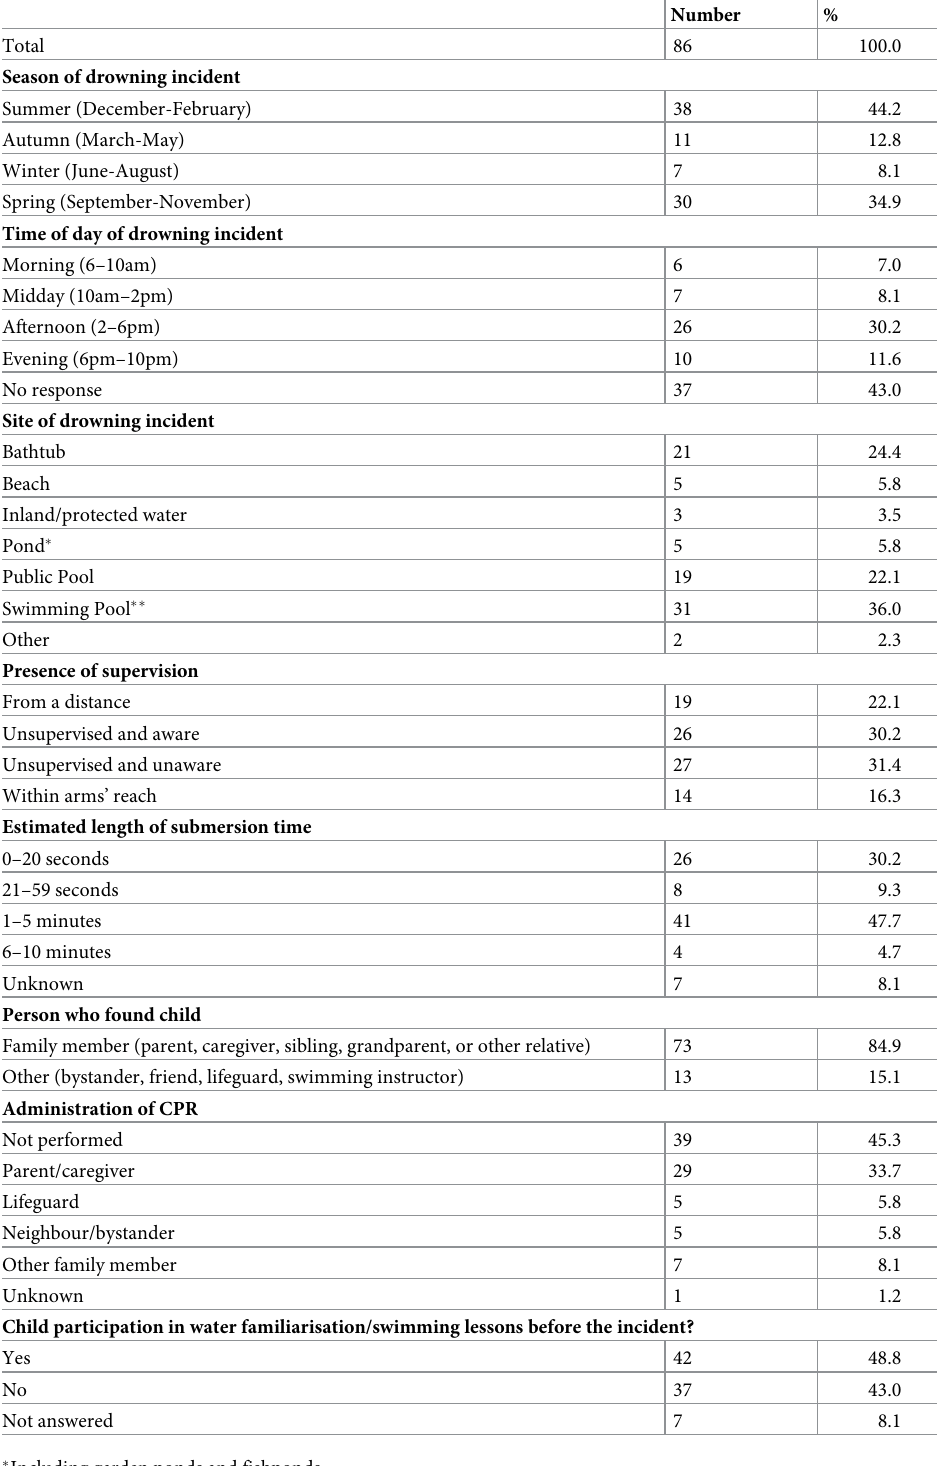
Table 3. Drowning incident